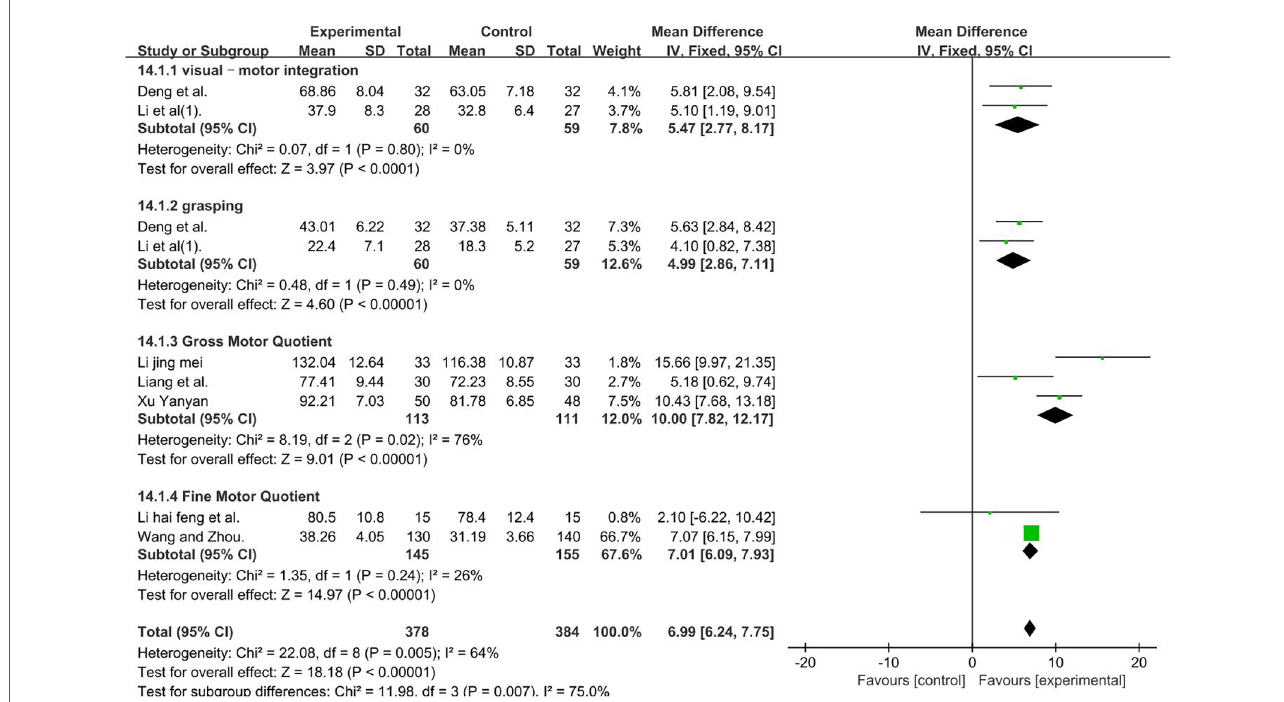
FIGURE 12 Forest plot showing MD (with 95% CI) for PDMS of the included studies comparing the experimental and control groups. Note: PDMS – visual – motor integration: fi xed-effect model [MD=5.47; 95% CI (2.77, 8.17); P <0.01]. PDMS – grasping: fi xed-effect model [MD=4.99; 95% CI (2.86, 7.11); P <0.01]. PDMS – FMQ: random-effect model [ I 2 =76%; MD=10.20; 95% CI (5.24, 15.15); P <0.01]. PDMS – GMQ: fi xed-effect model [MD=7.01; 95% CI (6.09, 7.93); P <0.01]. Those analysis results were statistically signi fi cant.